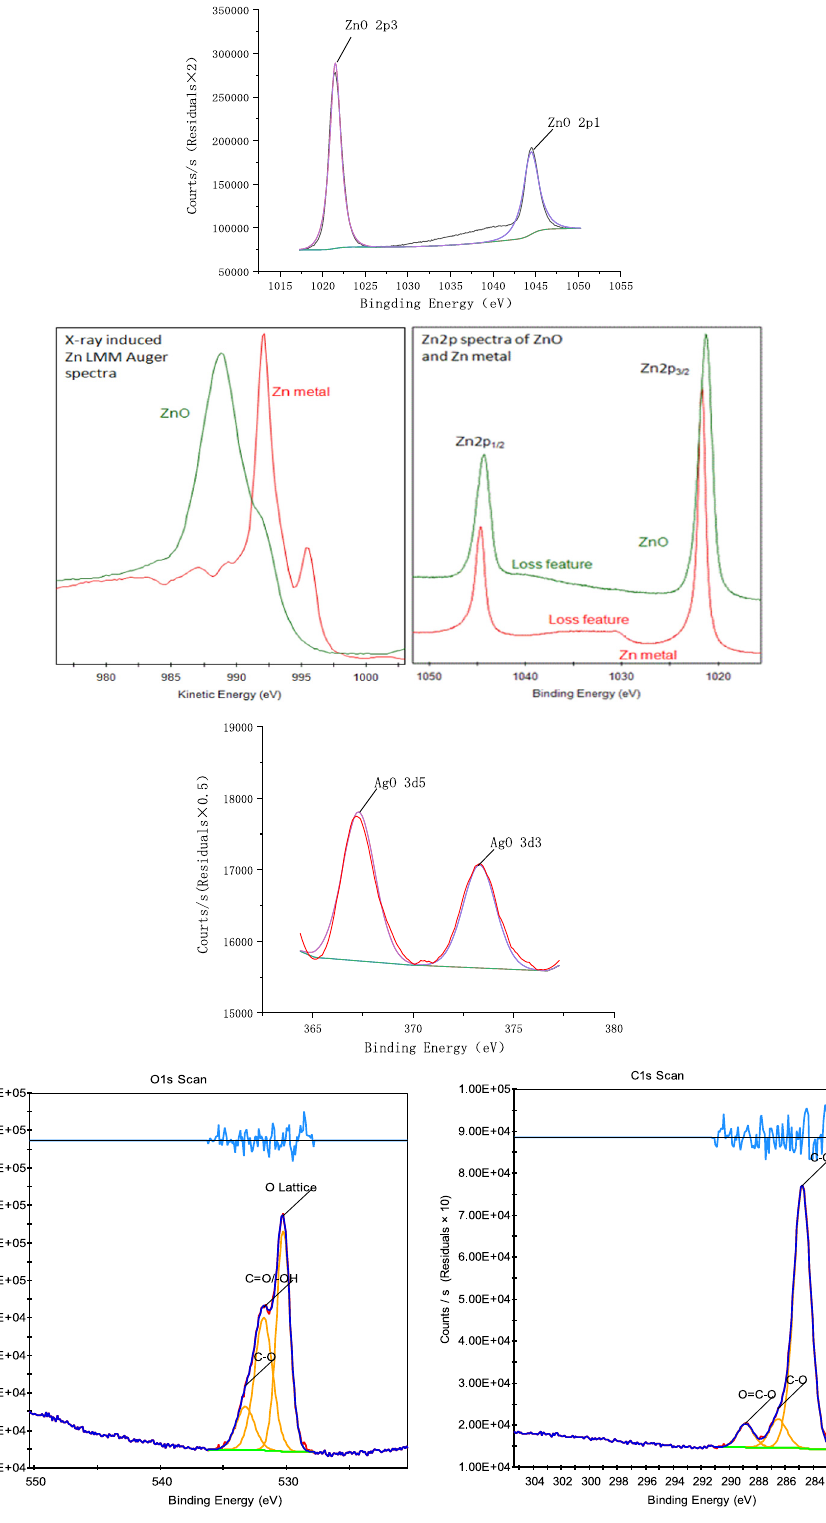
Figure 5: Full spectrum XPS analysis diagram of